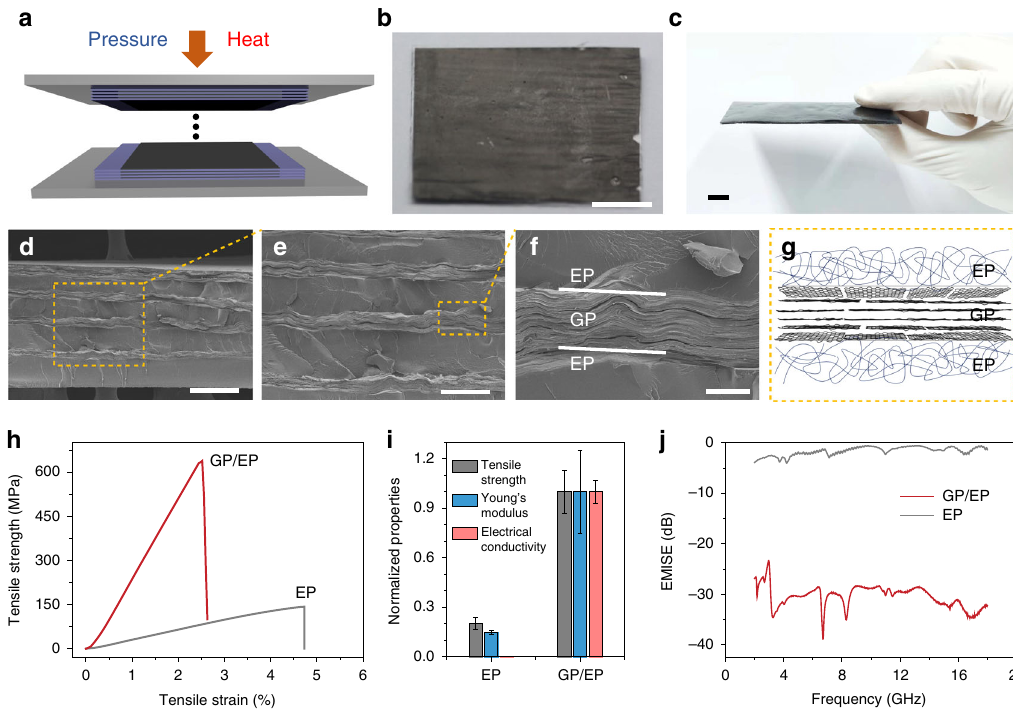
Fig. 7 Graphene paper laminated composites. a − c Schematic ( a ) and photographs ( b , c ) of the laminated composites consisting of EP and GPs. d − g SEM images and schematic of the laminated composite, showing a alternatively laminated structure. h Tensile curves of the laminated composites (8%-GP/EP) and pure EP. i Comparison of tensile strength, Young ’ s modulus and electrical conductivity between the 8%-GP/EP composite and pure EP. All data are normalized by the properties of 8%-GP/EP composite, which shows average tensile strength, modulus, and electrical conductivity of 540 MPa, 20 GPa, and 2.9 × 10 4 S m − 1 , respectively. Error bars are de fi ned as s.d. j EMI shielding properties of the 8%-GP/EP composite and pure EP in 2 − 18 GHz. Scale